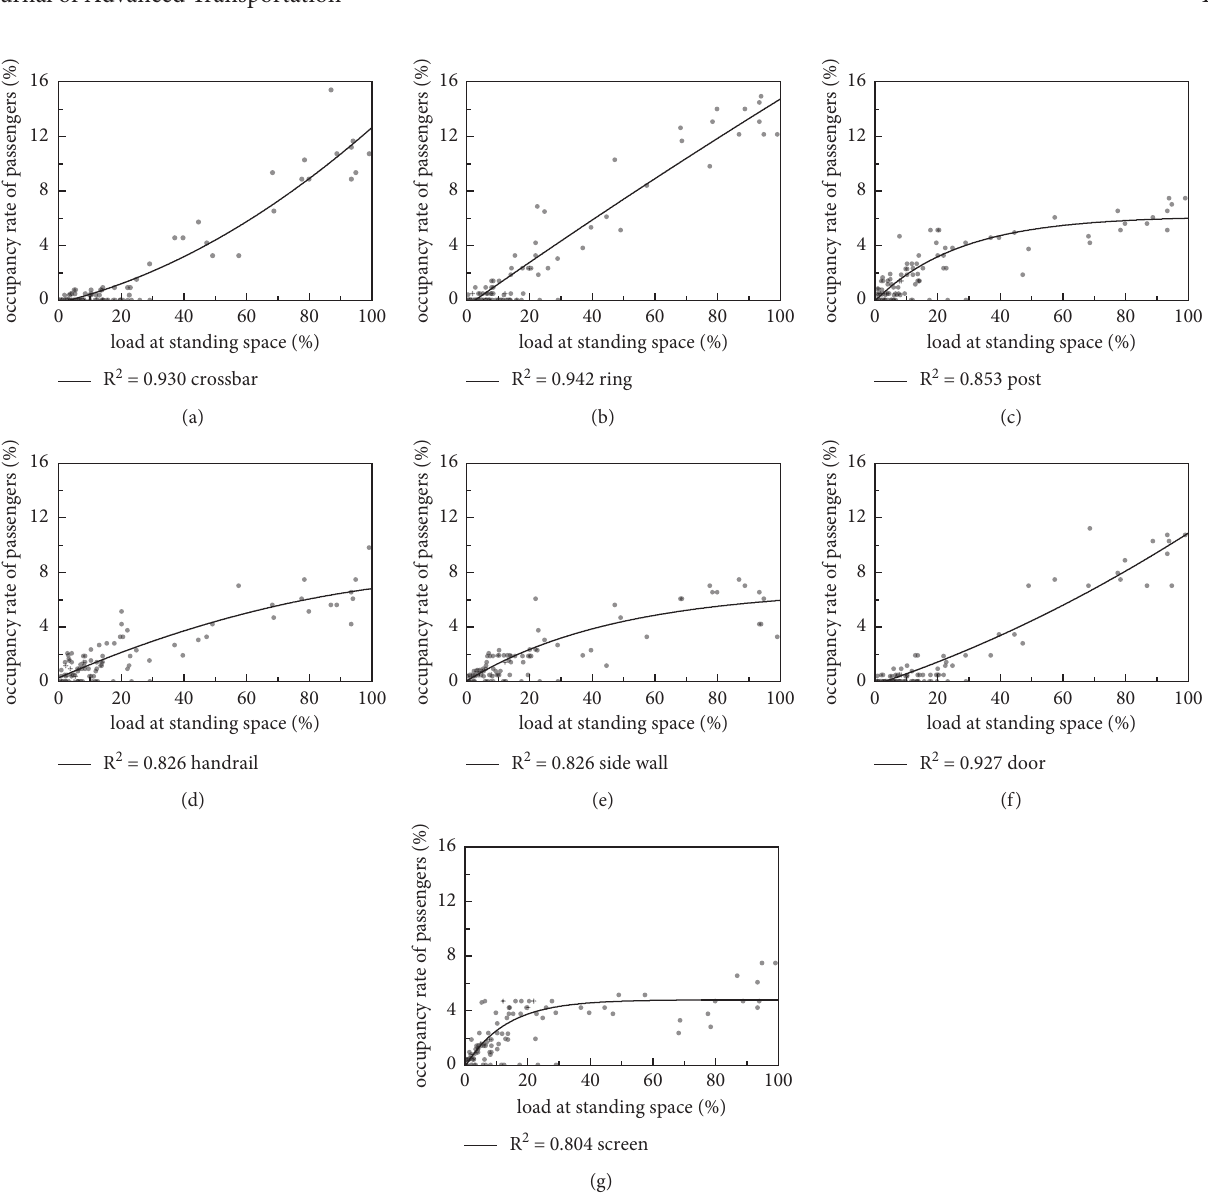
Figure 9: Growth curve of occupancy of standing space by passengers using different auxiliary standing facilities. (a–g) Load at standing space